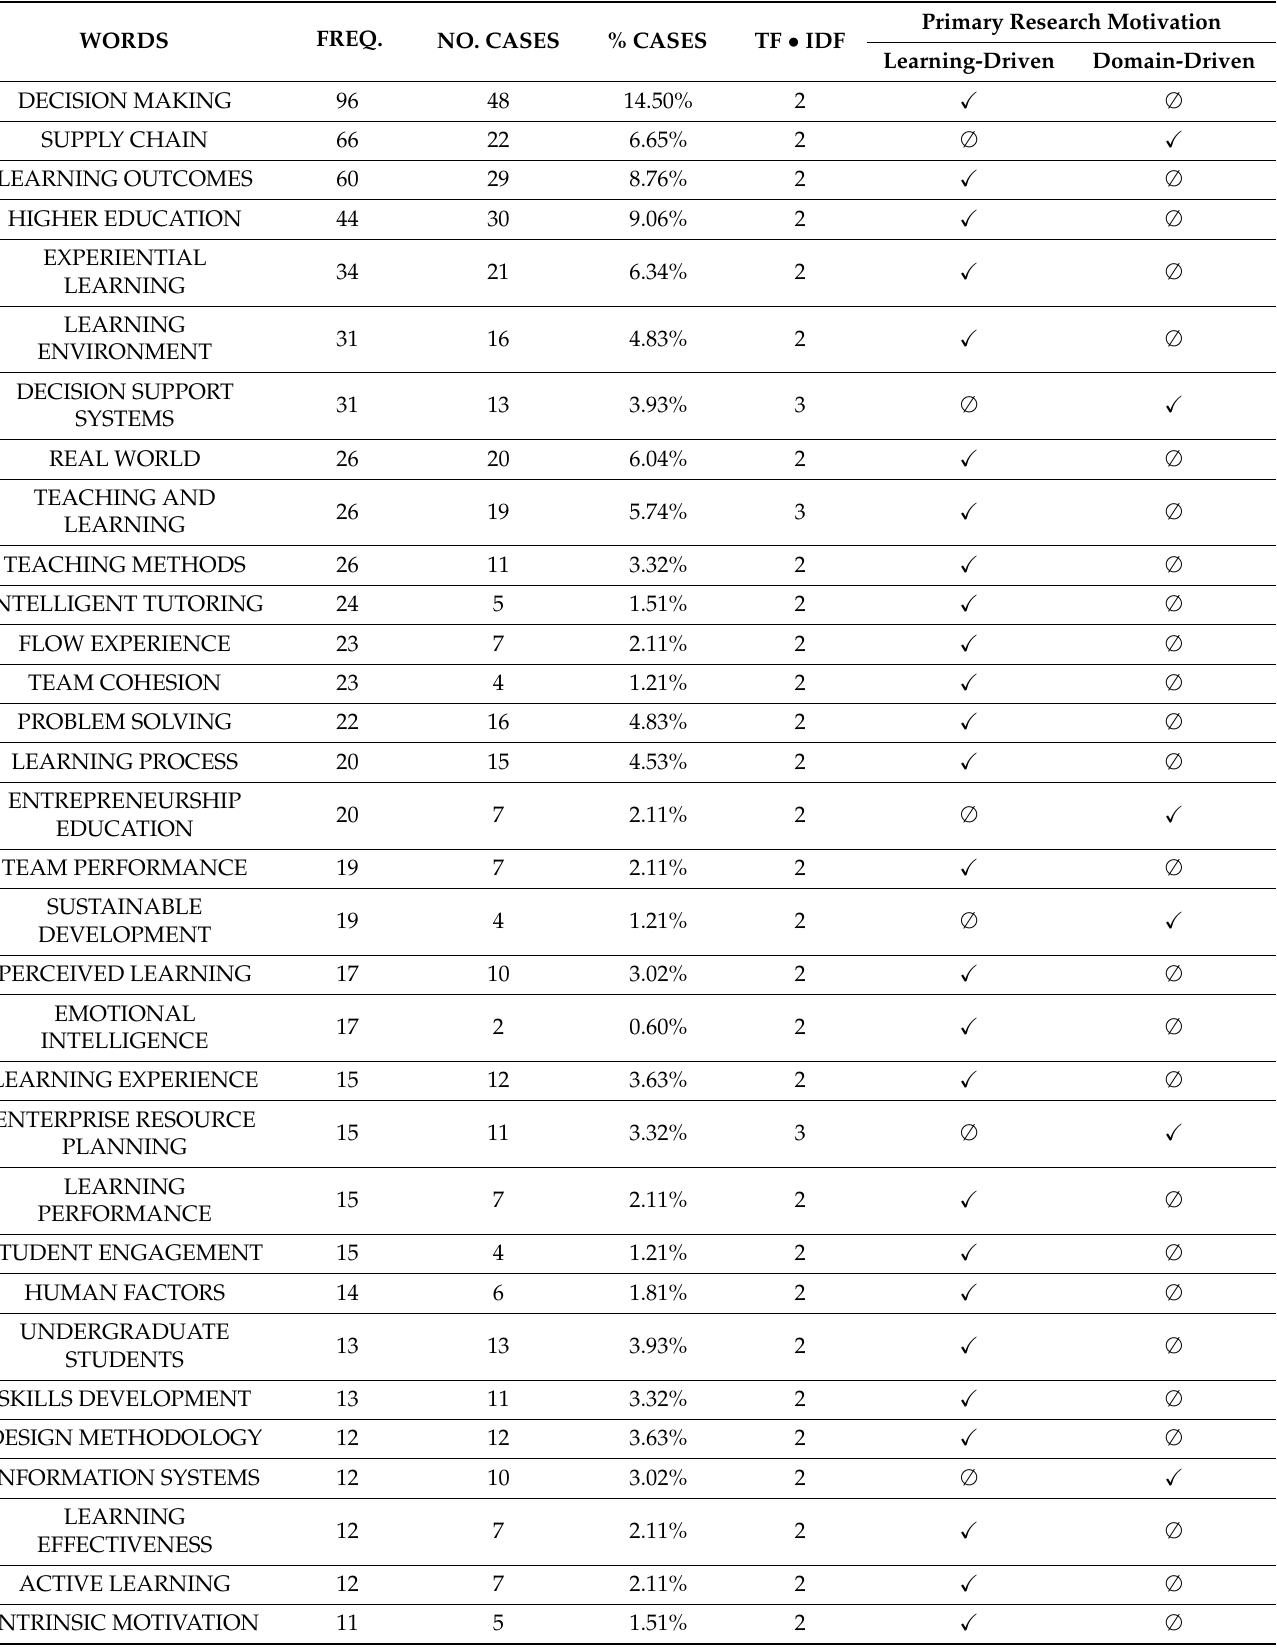
Table 6. Extracted phrases (10+